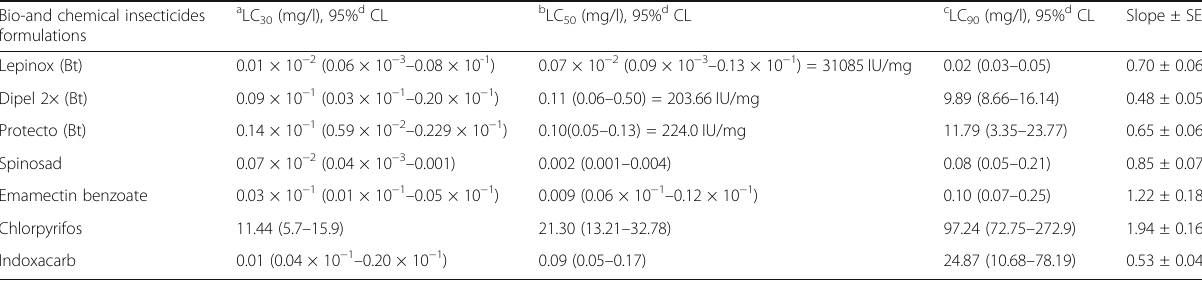
Table 2 Toxicity of the tested bio-and chemical insecticides against the early 2nd instar larvae of Tuta absoluta (treated by leaf dipping